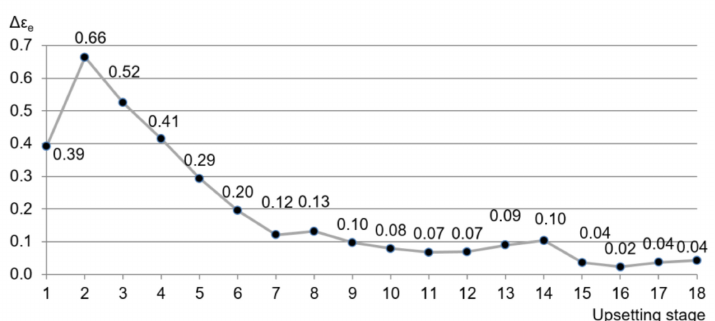
Figure 9. Dependence of ∆ ε e on the stage of the process at axis c .